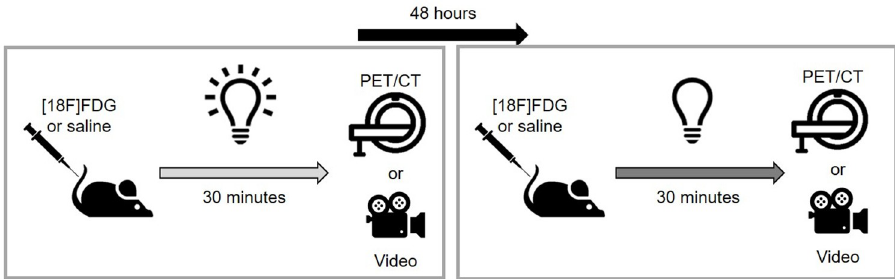
Fig 1. Experimental design. Awake animals were exposed to light or darkness in two different days during 33.6 ± 2.7 min before the PET/CT acquisition (n = 24) or video recording (n = 15). Before the illumination condition animals received an intravenous administration of [18F]FDG or